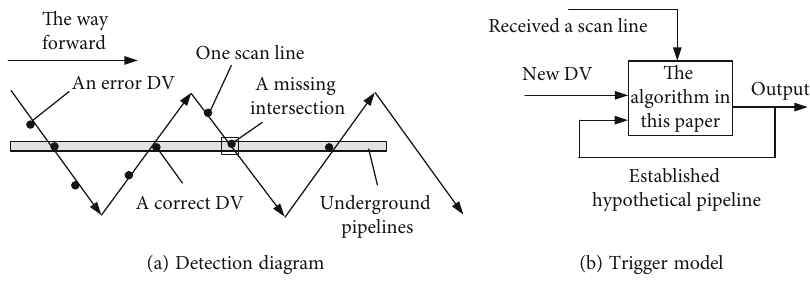
Figure 5: Visual schematic diagram of